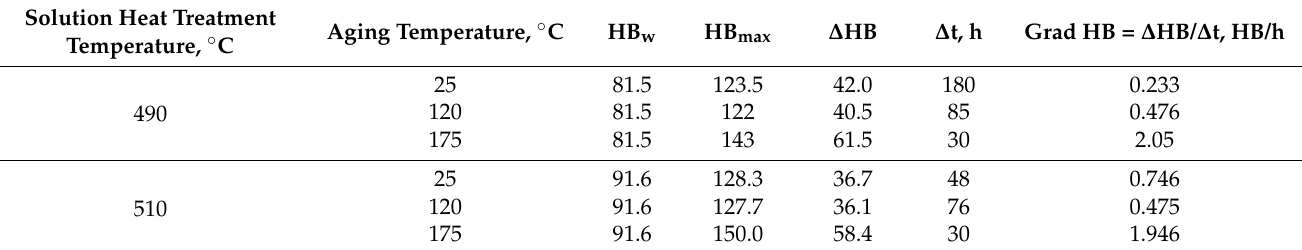
Table 6. Parameter values determined from aging curves necessary to determine hardness gradient grad HB. Solution Heat Treatment Temperature, ◦